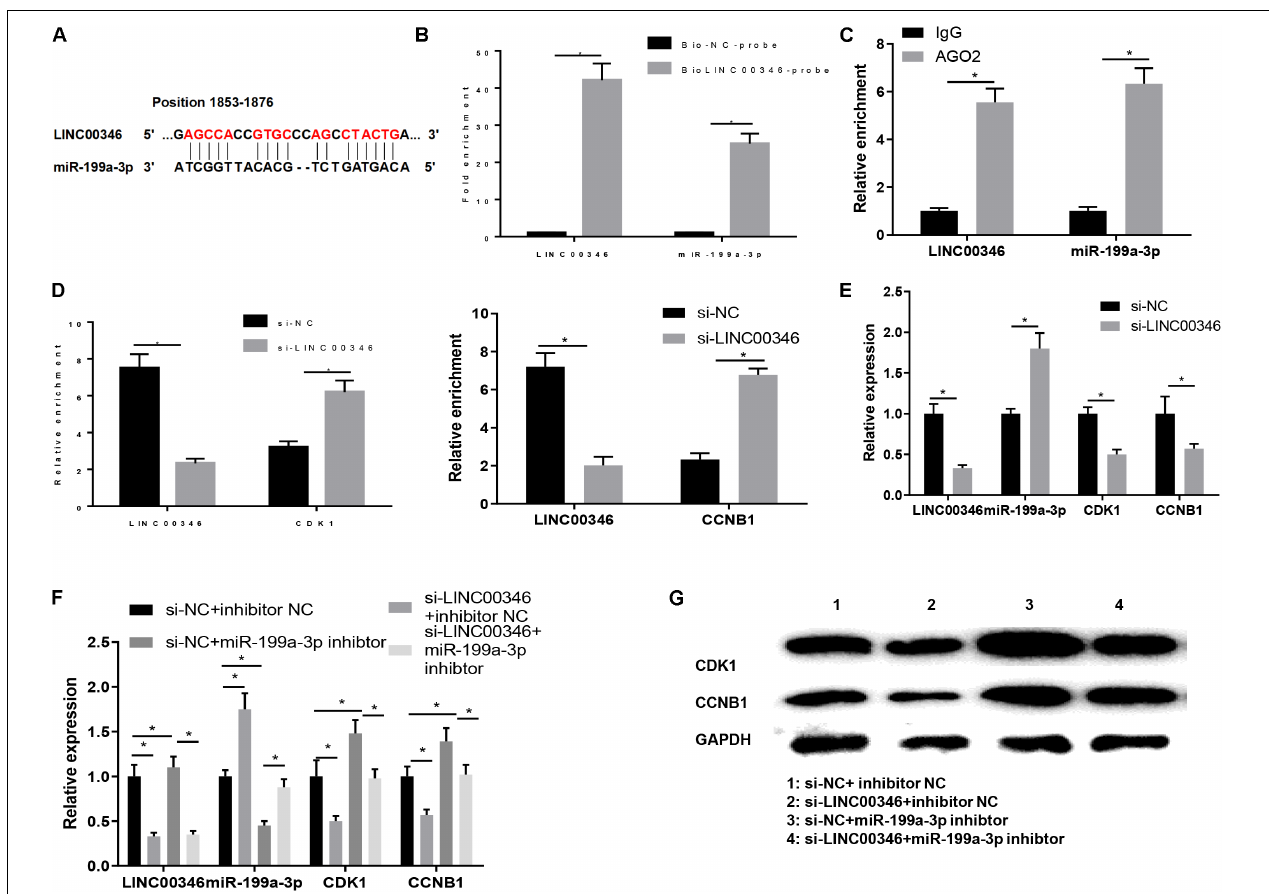
FIGURE 6 | LINC00346 regulates the expression of CDK1 and CCNB1 by sponging miR-199a-3p. (A) The binding sites of LINC00346 and miR-199a-3p; (B) RNA pull-down assay was used to verify the interaction between LINC00346 and miR-199a-3p, red letters indicate predicted binding sites of LINC00346 and mRNA-199a-3p (C) RIP was used to detect the binding of LINC00346 and miR-199a-3p in each group; (D) RIP was used to detect changes in LINC00346, CDK1 and CCNB1 binding to miR-199a-3p in each group; (E) Expression changes of LINC00346, miR-199a-3p, CDK1 and CCNB1 after LINC00346 silencing were detected by qRT-PCR; (F) The expressions of LINC00346, miR-199A-3p, CDK1 and CCNB1F in each group were detected by qRT-PCR and WB, respectively: The expressions of LINC00346, miR-199a-3p, CDK1 and CCNB1; (G) Protein expressions of CDK1 and CCNB1. *represents P <